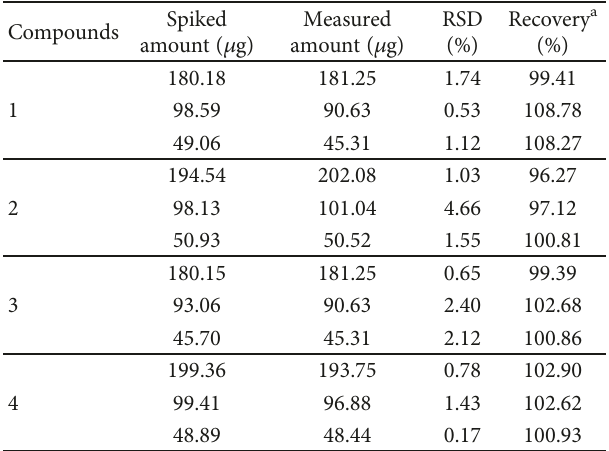
Neferine (1), 1,2,3,4-tetrahydro-1-[(4-hydroxyphenyl) methyl]-2- methyl-7-isoquinolinol (2), 1-hydroxy-2-methylpropene (3), and 3-(prop-1-enyl)benzene-1,2,4,5-tetrol (4).